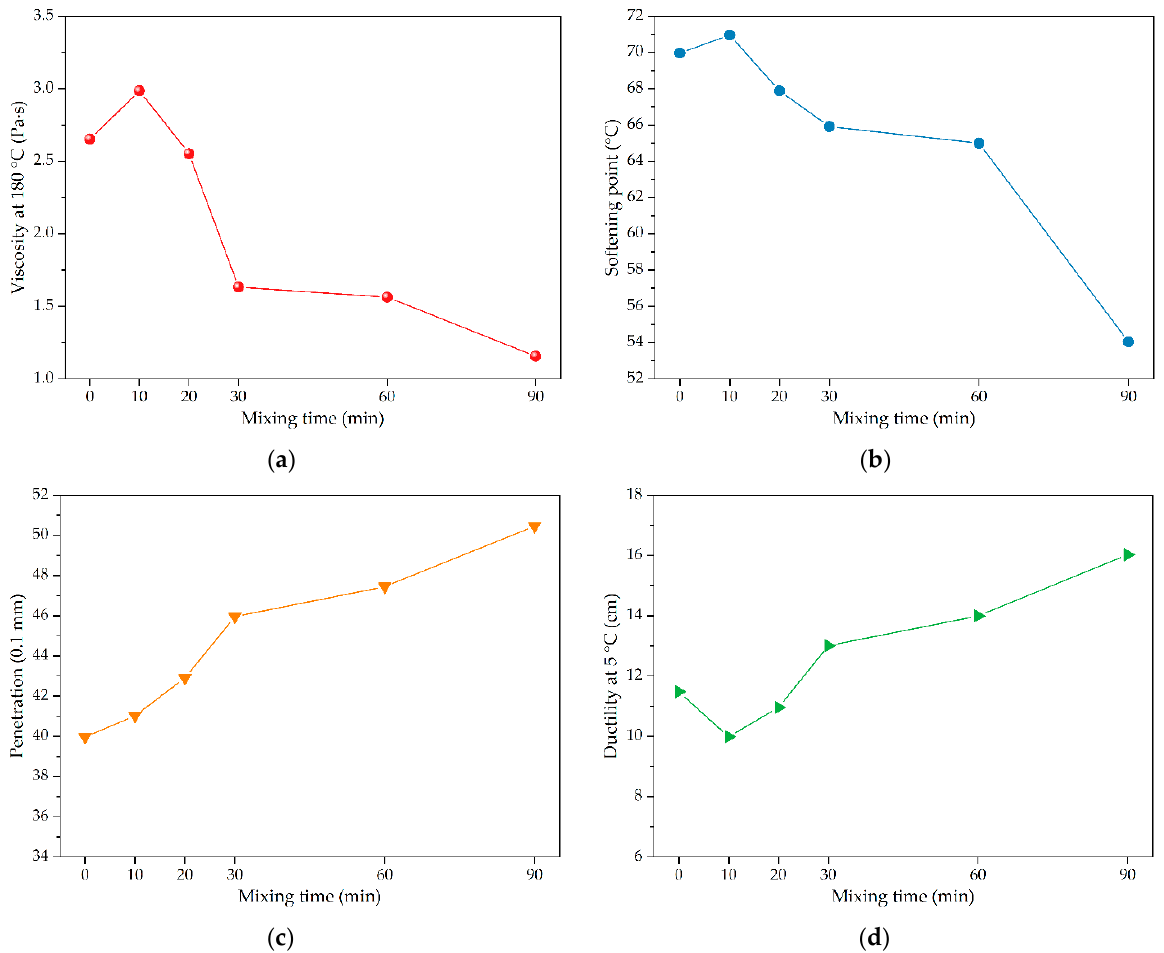
Figure 5. The physical properties of asphalt modified by crumb rubber treated with different mixing time (i.e., 0, 10, 20, 30, 60, 90 min): ( a ) viscosity at 180 °C; ( b ) softening point; ( c ) penetration; ( d ) time (i.e., 0, 10, 20, 30, 60, 90 min): ( a ) viscosity at 180 ◦ C; ( b ) softening point; ( c ) penetration; ductility at 5 °C. ( d ) ductility at 5 ◦